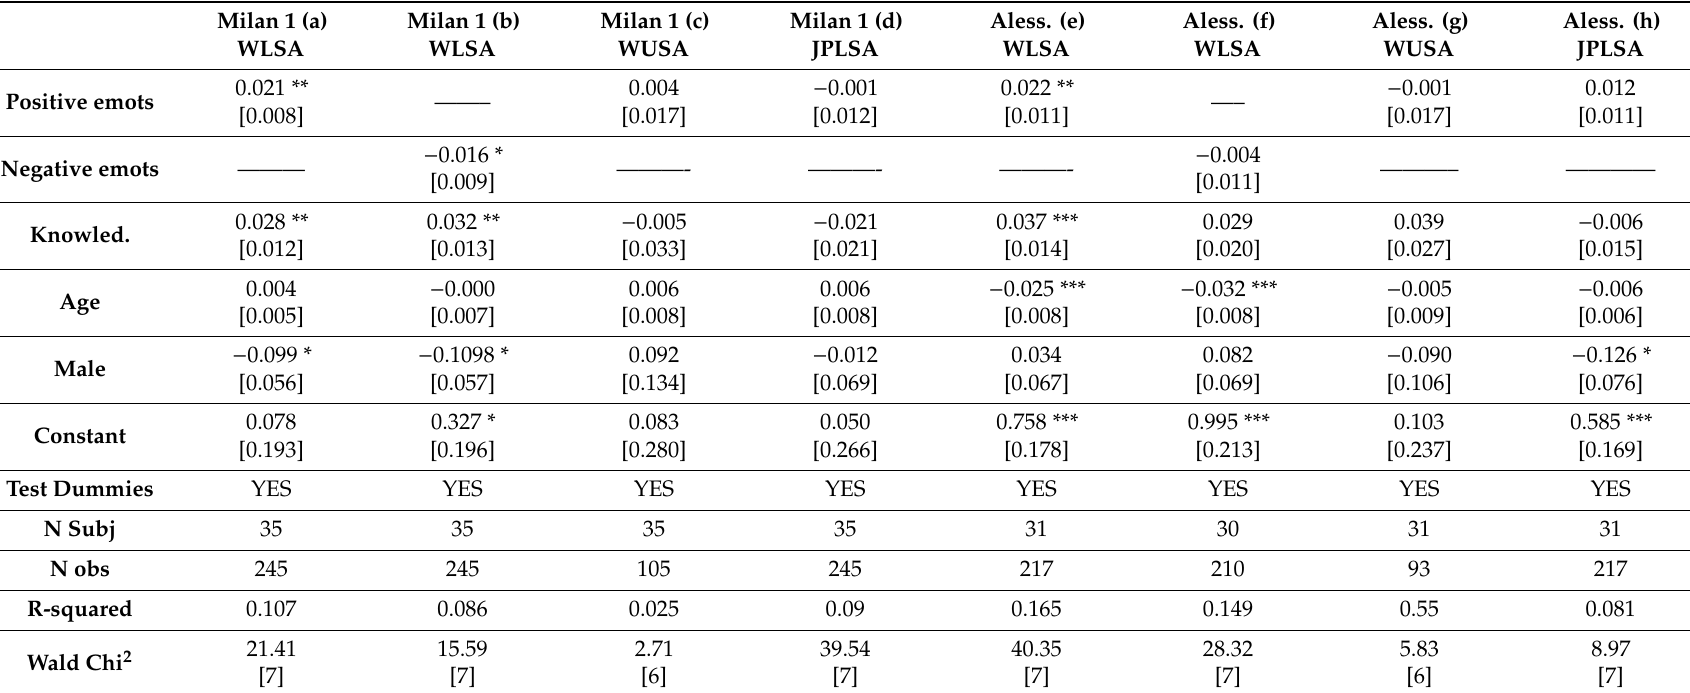
Table 5. Bounded Subadditivity Test: Milan 1 and Alessandria